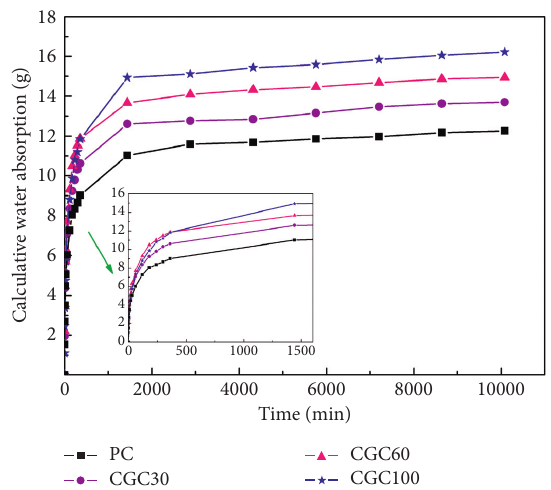
Figure 4: Cumulative water absorption of different specimens.